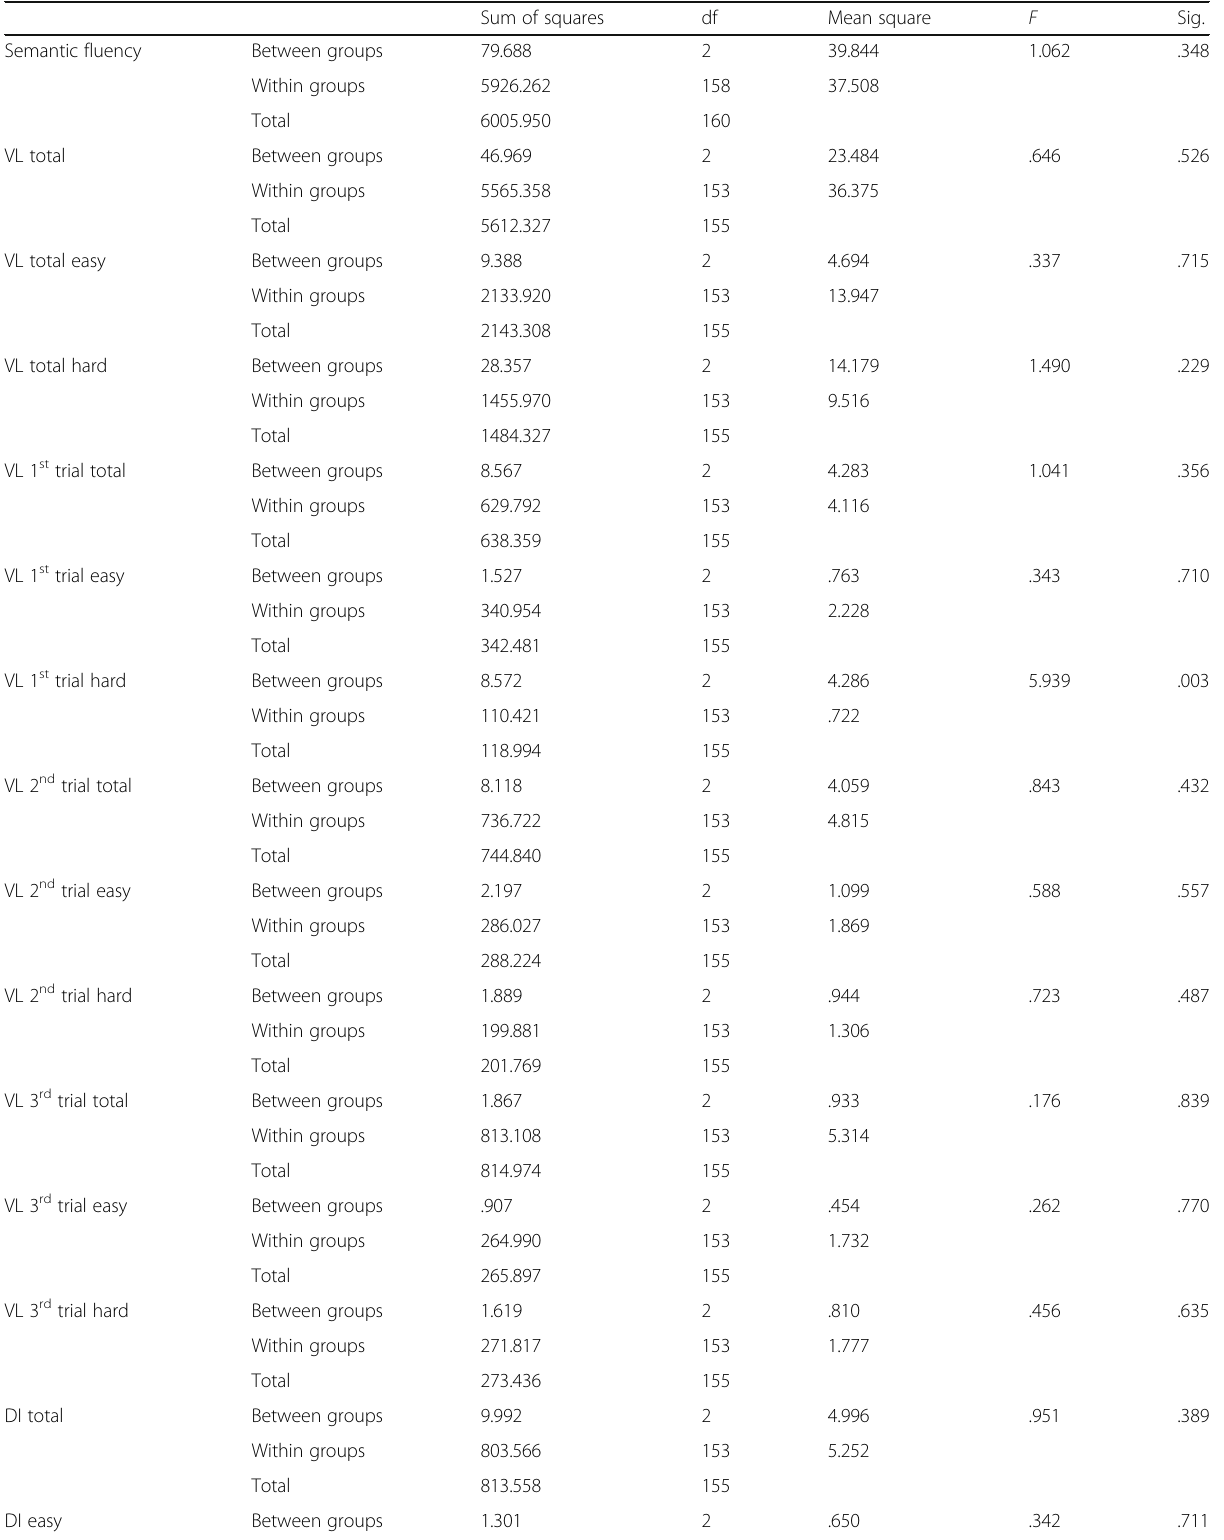
Table 5 Significant F test between Groups as regards education ANOVA